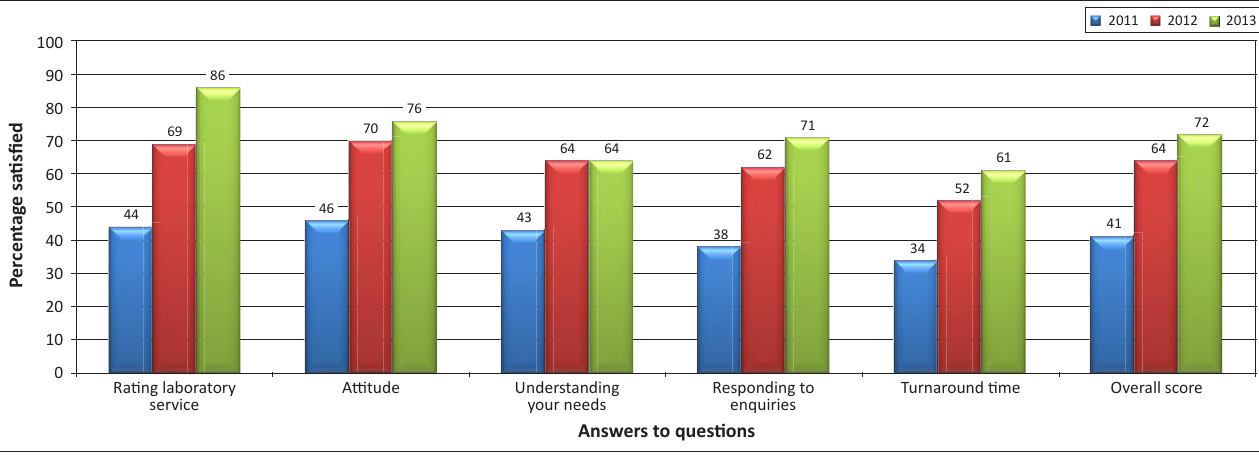
FIGURE 2b: Percentage of clinicians who reported satisfaction with selected services (2011 to